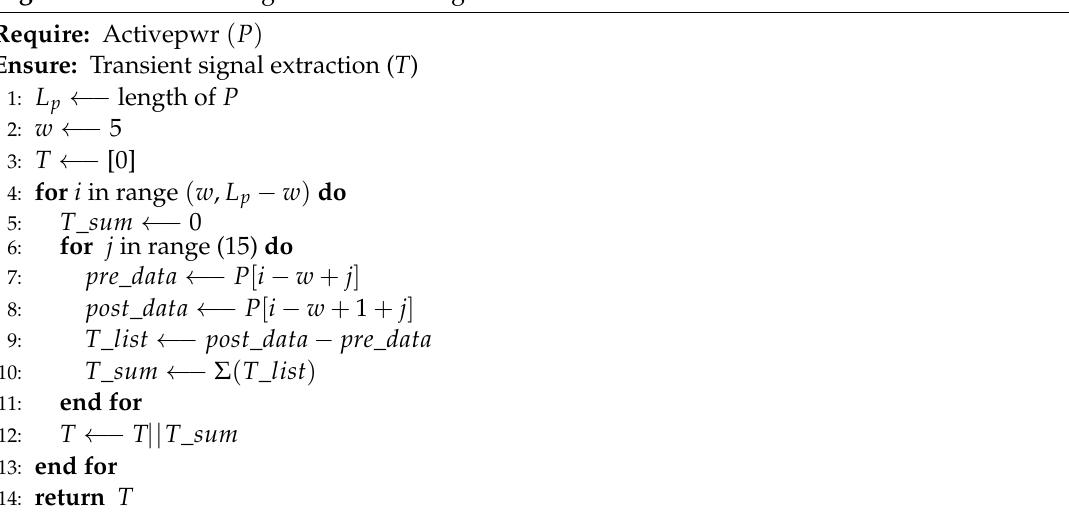
Algorithm 3 Transient signal extraction algorithm